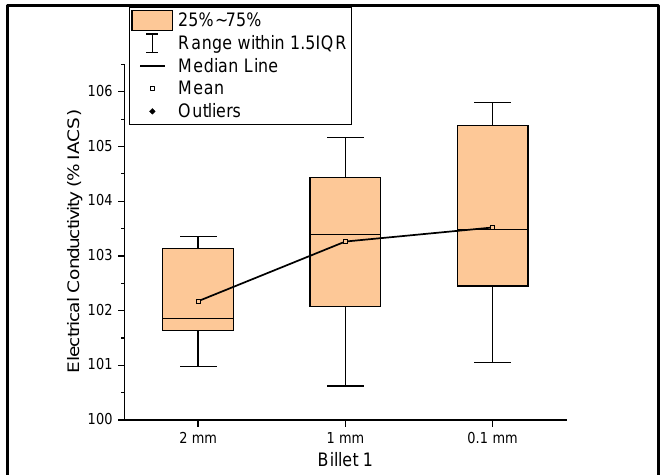
Figure 1. The electrical conductivity of Billet 1 at different cross-sectional sizes.